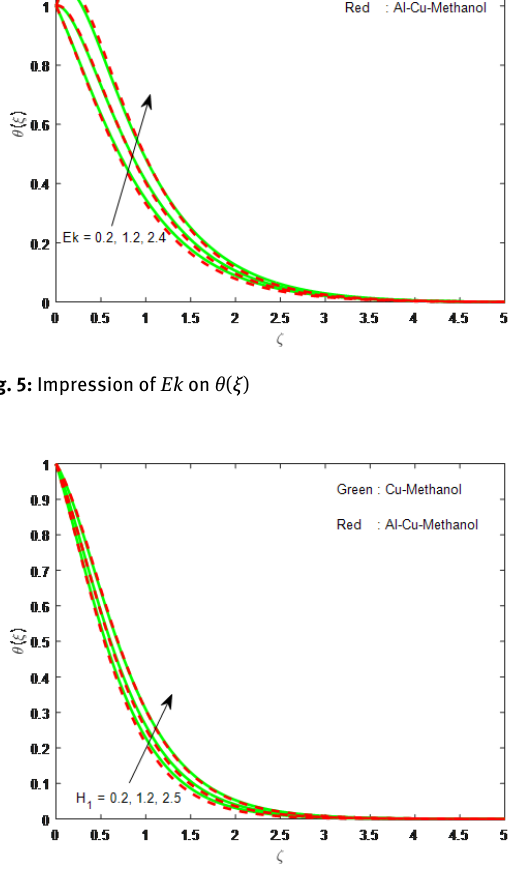
= 0.2, Fig. 6: Impression of H 1 on θ ( ξ ) 1 = 0.3, therefore 2 tation of θ ( ξ ) vs negative values of H . For this graph, we 2 taken H =−0.4, H = −0.2, −1.4, −2.6. It is expected 1 2